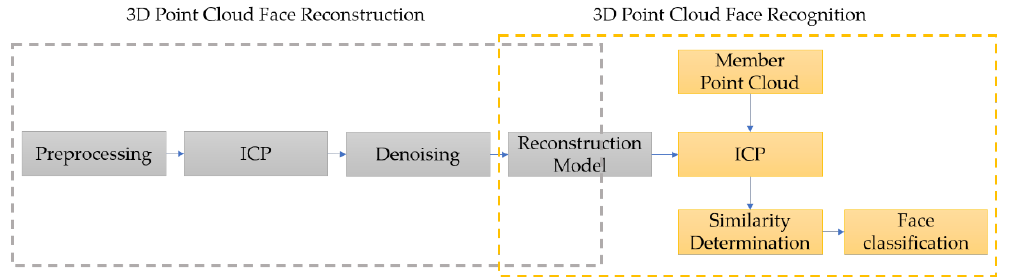
Figure 18. Flowchart of 3D facial reconstruction and recognition.